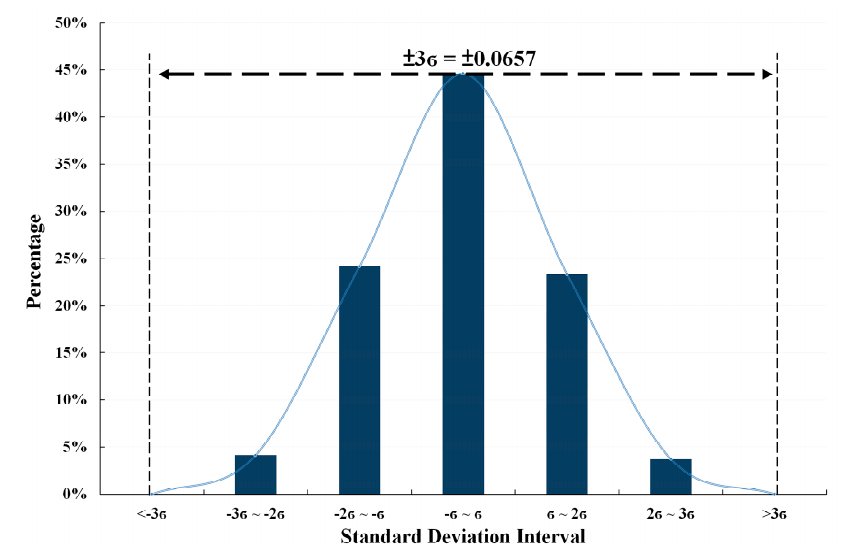
Figure 15. The standard deviation of the measurement results.